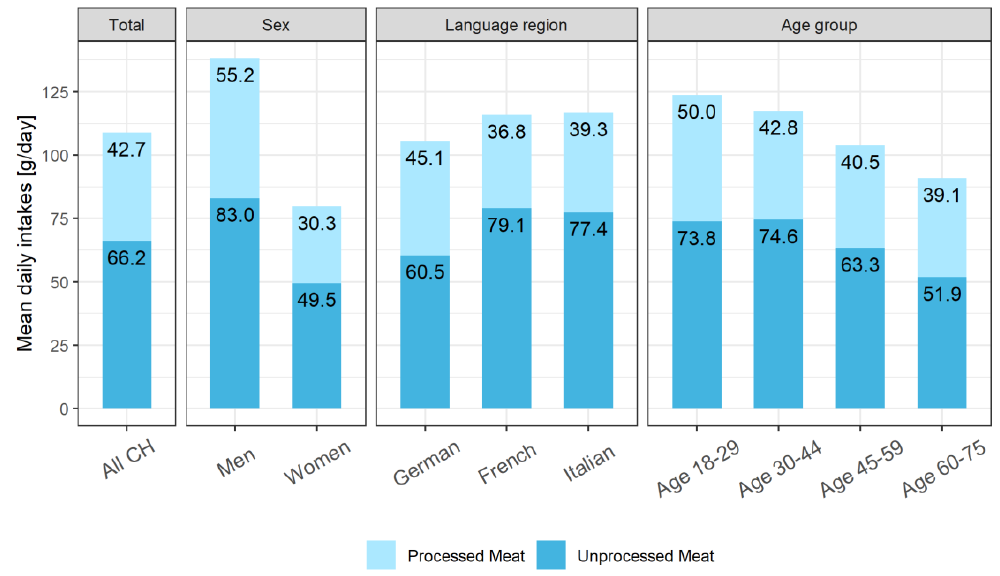
Figure 1. Comparison of mean daily intakes of processed and unprocessed meat for total population (All CH) and by sex, language region, and age group. All data weighted for sex, age, marital status, major area of Switzerland, household size, nationality, season, and weekday. 220